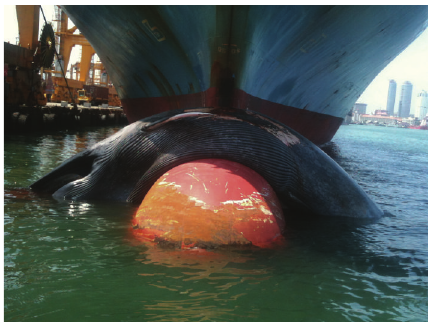
Figure 4: Blue whale on bow of container ship in Colombo Harbour, Sri Lanka, on the 20th of March 2012 (photo credit: Sopaka